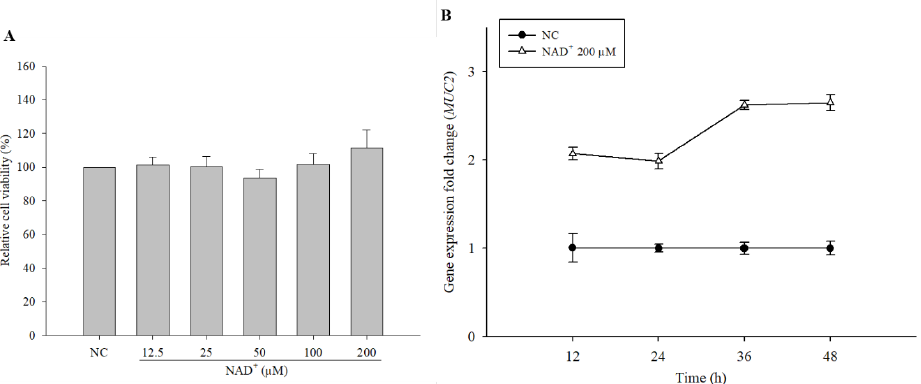
ff ect of exogenous nicotinamide adenine dinucleotide (NAD + ) on LS 174T Figure 1. Cytotoxic effect of exogenous nicotinamide adenine dinucleotide (NAD + ) on LS 174T goblet Figure 1. Cytotoxic e goblet cells and expression level of MUC2 by